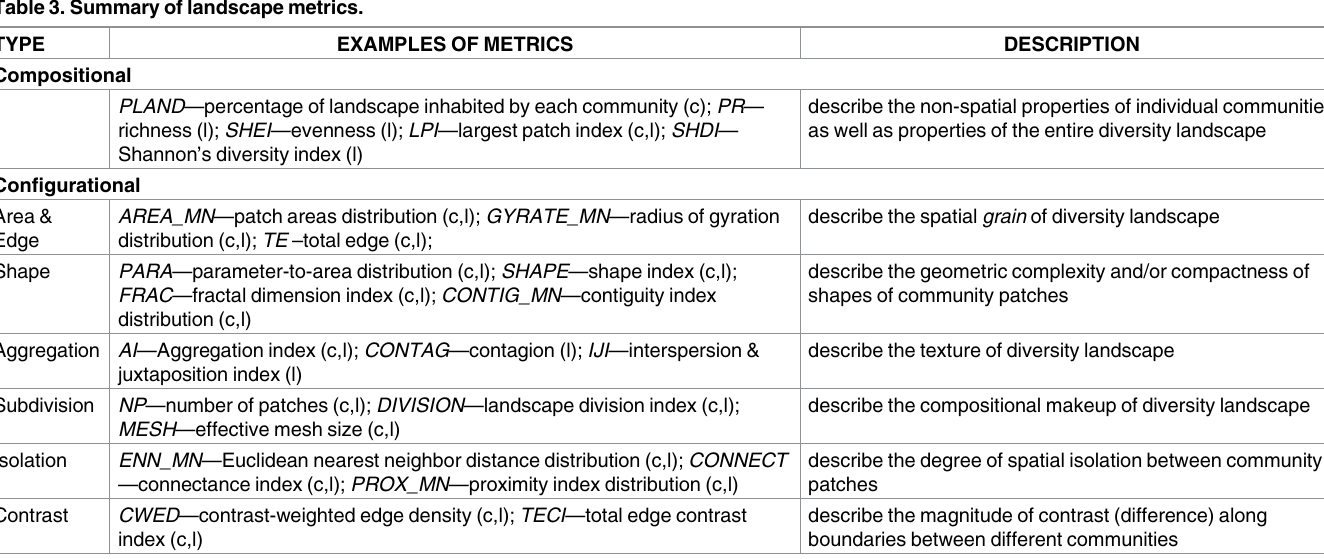
Table 3. Summaryof landscape metrics.